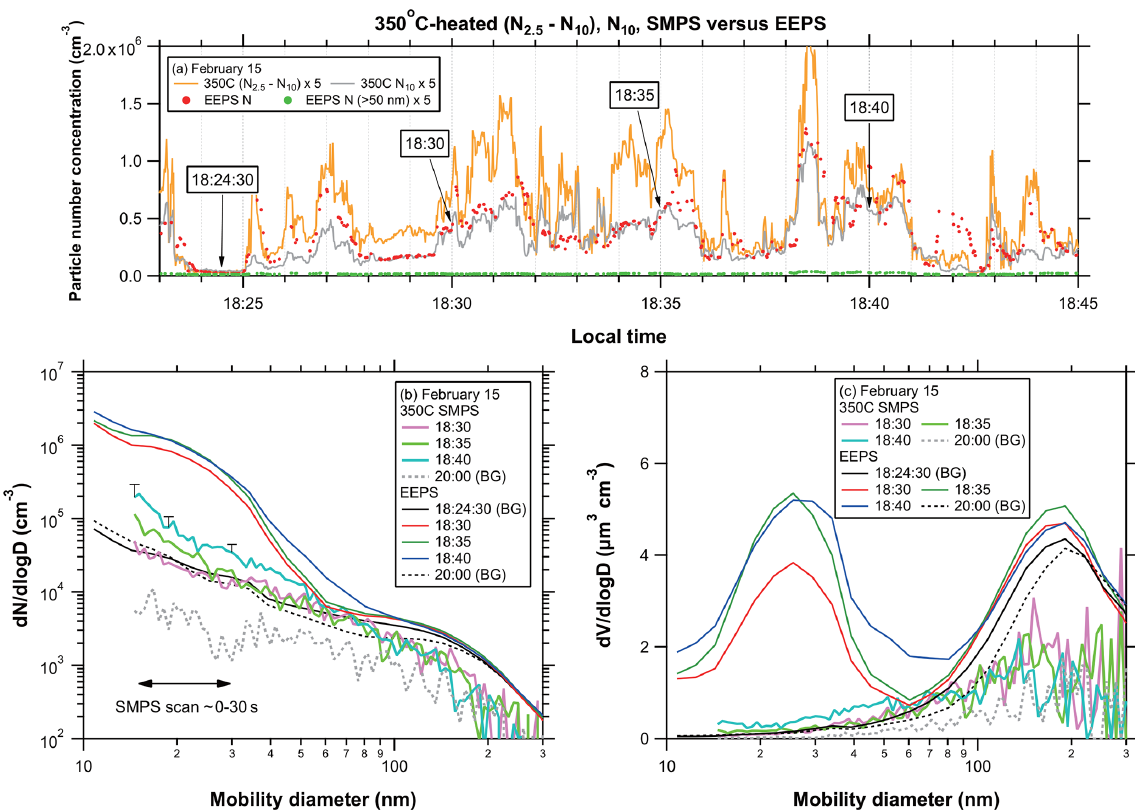
Figure 7. (a) Time series of 350 ◦ C heated N 2 . 5 – N 10 (orange), 350 ◦ C heated N 10 (gray), total particle number concentrations derived from the EEPS data (EEPS N, red), and particle number concentrations for a diameter range of > 50nm measured by the EEPS (EEPS N ( > 50nm), green) obtained at 18:23–18:45LT on 15 February 2018. The 350 ◦ C heated N 2 . 5 – N 10 , N 10 , and EEPS N ( > 50nm) data are multiplied by a factor of 5 for clarity. (b) Particle number size distributions measured simultaneously by the EEPS and 350 ◦ C heated SMPS for selected time periods indicated in (a) . The average method for the EEPS is the same as that used in Fig. 6b. “BG” denotes a time period without enhancements of the aerosols and CO 2 . The upper ends of the error bars indicate the particle number concentrations incorporating the penetration efficiencies of particles through the sampling tubes and evaporation tube (Figs. 3 and S1). (c) Same as (b) but for the particle volume size